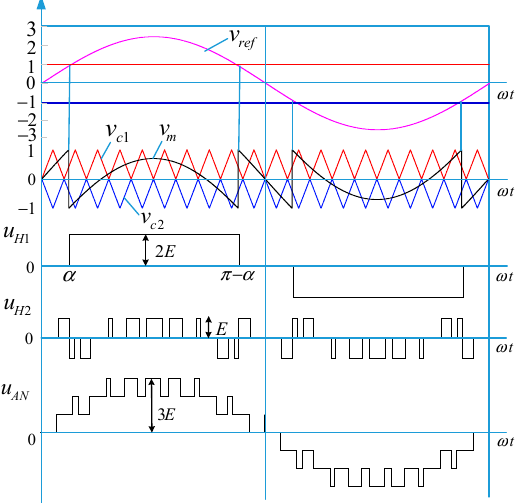
Figure 3. Schematic diagram of traditional mixed modulation strategy. (Reference [13]).